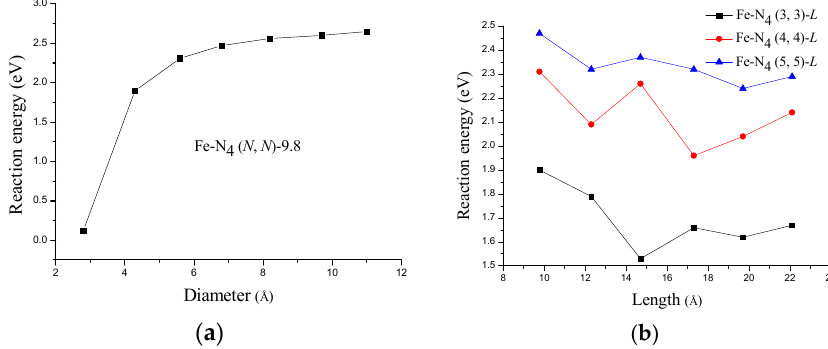
Figure 2. Reaction energies required for ( a ) Fe − N 4 ( N , N )-9.8 with different tube diameters ( N = 2–8, the CNT length is 9.8 Å); and ( b ) Fe − N 4 ( N , N )- L with different tube lengths ( N = 3–5, L = 9.8–22.1 Å).